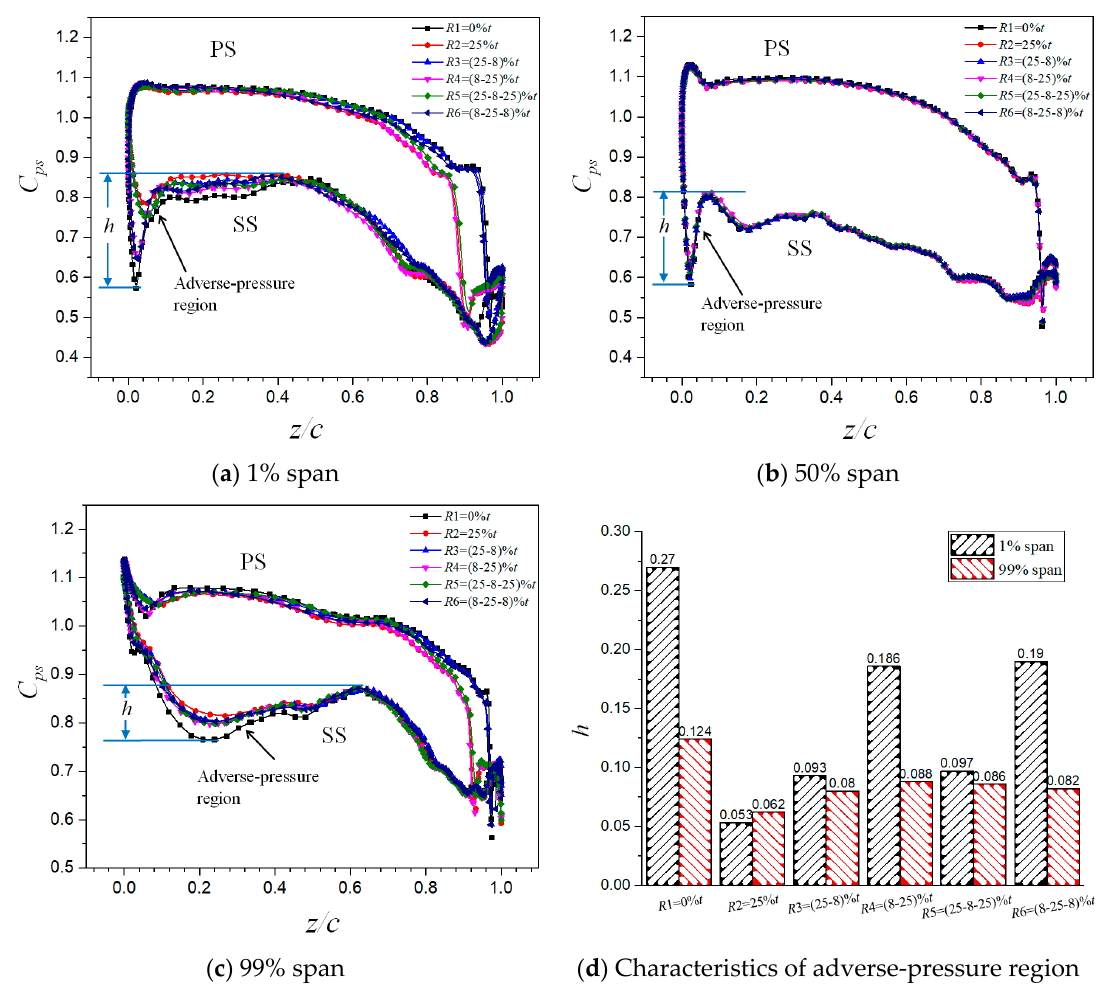
Figure 10. C ps distribution for S2 at 1% span ( a ), 50% span ( b ), and 99% span ( c ) blade and characteristics of adverse-pressure region ( d ).